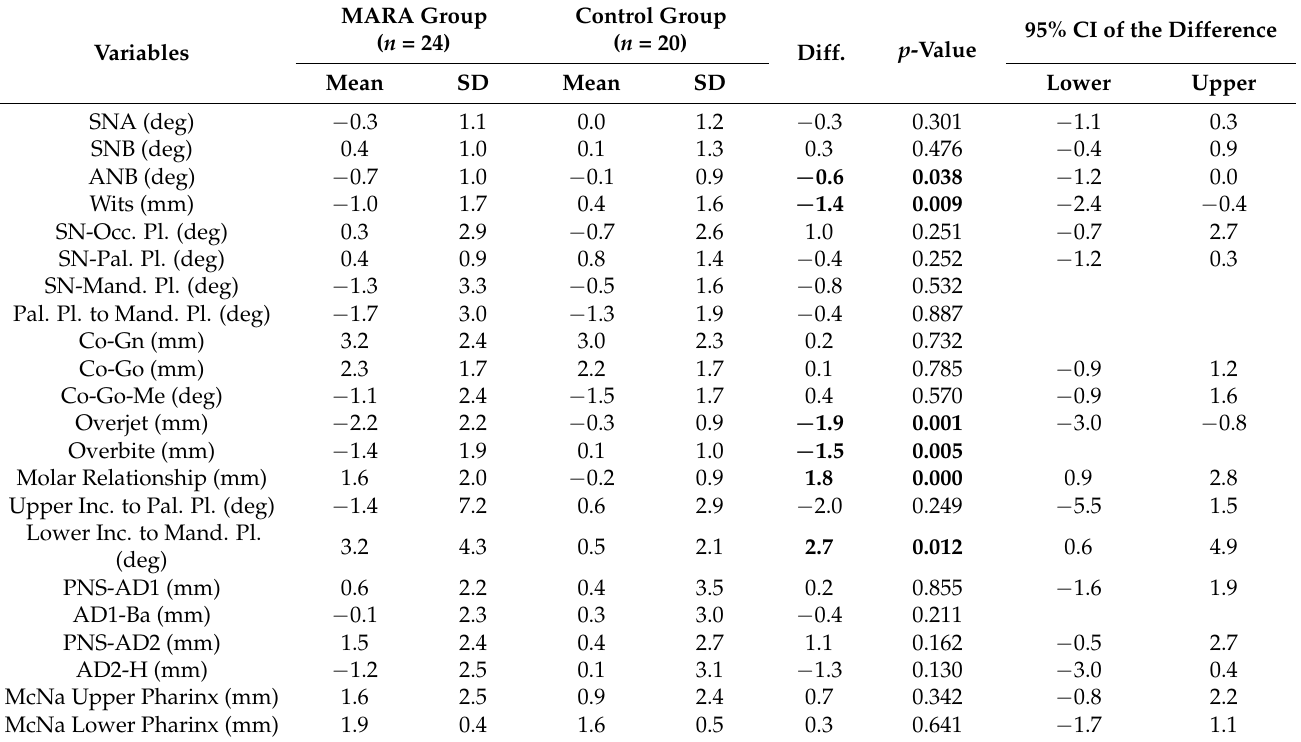
Table 3. Descriptive statistics and statistical comparisons (independent-samples t -tests or Mann– Whitney U test) of the T2-T1